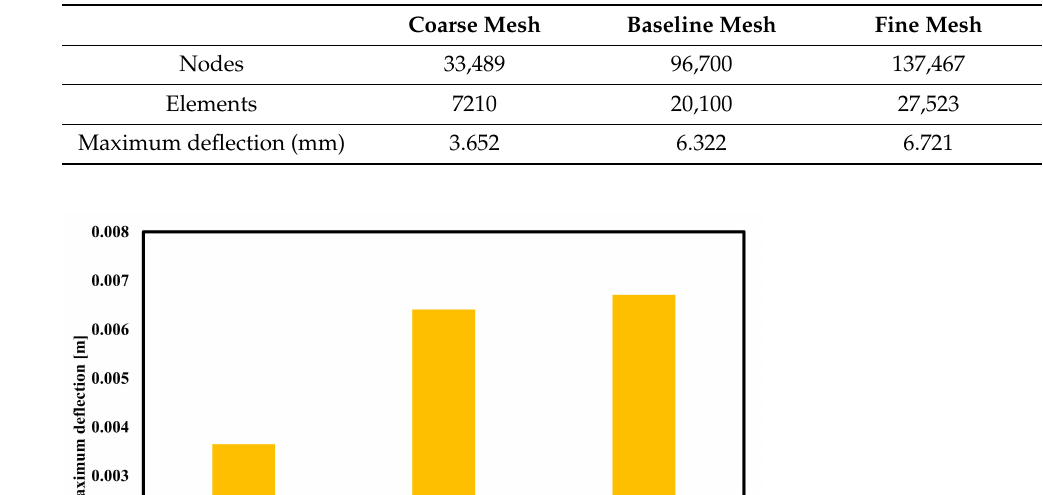
Table 6. Information on various meshes used in mesh sensitivity analysis.